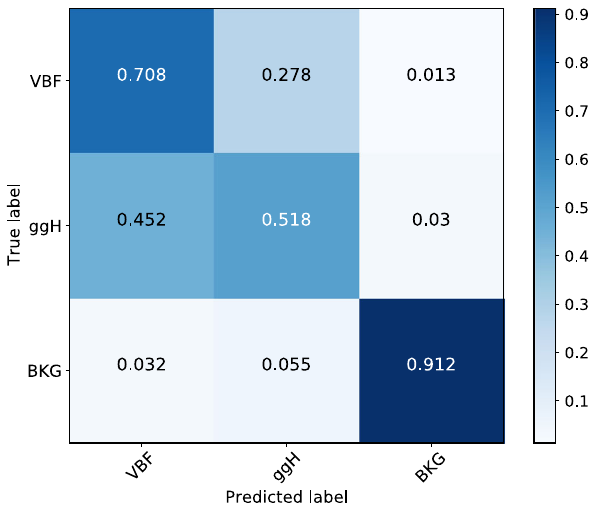
Fig. 4 Normalized distributions of the VBF-output on SM signal, ggH and background events in C1. The solid lines correspond to the distri- butions obtained on training sample, while the dots with statistical error bars stand for validation sample